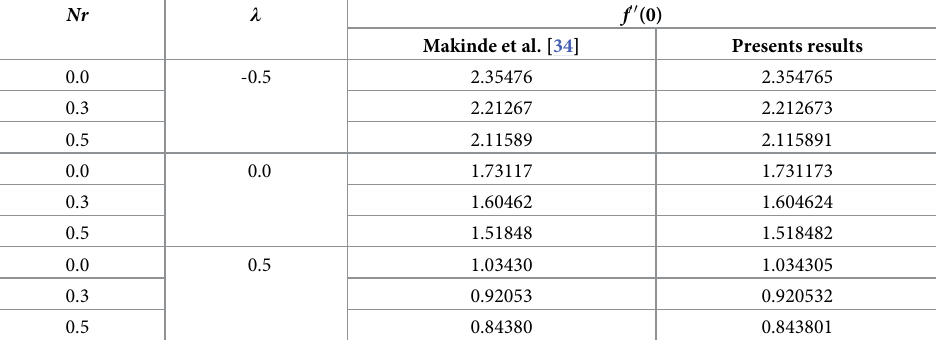
Table 1. Validation of the skin friction values with previously published results when M = 1.0, Ec = 0.1, Da ! 1 , and β ! 1 .